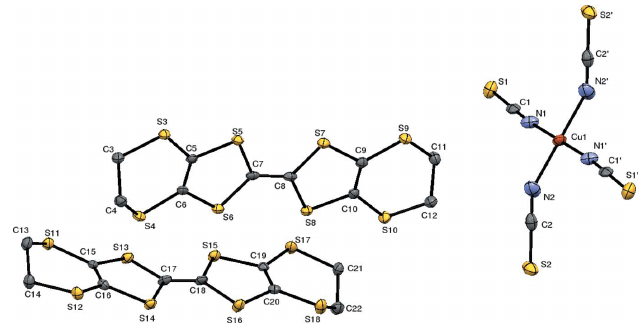
Figure 2 Molecular structure of (BEDT-TTF) 4 [Cu(NCS) 4 ], showing the BEDT- TTF molecule involved in the formation of a dimer (top), and the other BEDT-TTF molecule (bottom), as well as the centrosymmetric [Cu(NCS) 4 ] 2– dianion. Displacement ellipsoids are drawn at the 50% probability level. H atoms have been omitted for clarity. Primed atoms are generated by the symmetry operation ( (cid:3) x , 1 (cid:3) y , 2 (cid:3) z ).